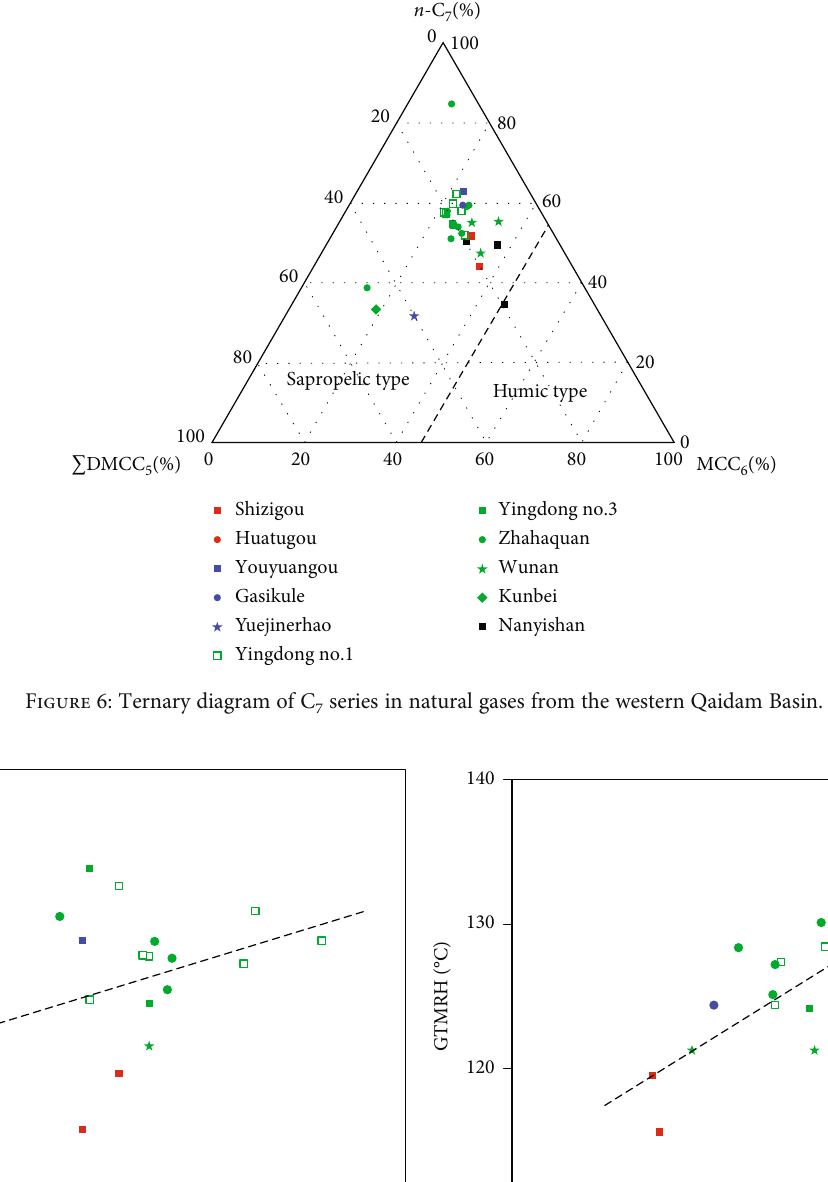
and (b) GTMRH vs. 2-MC 1